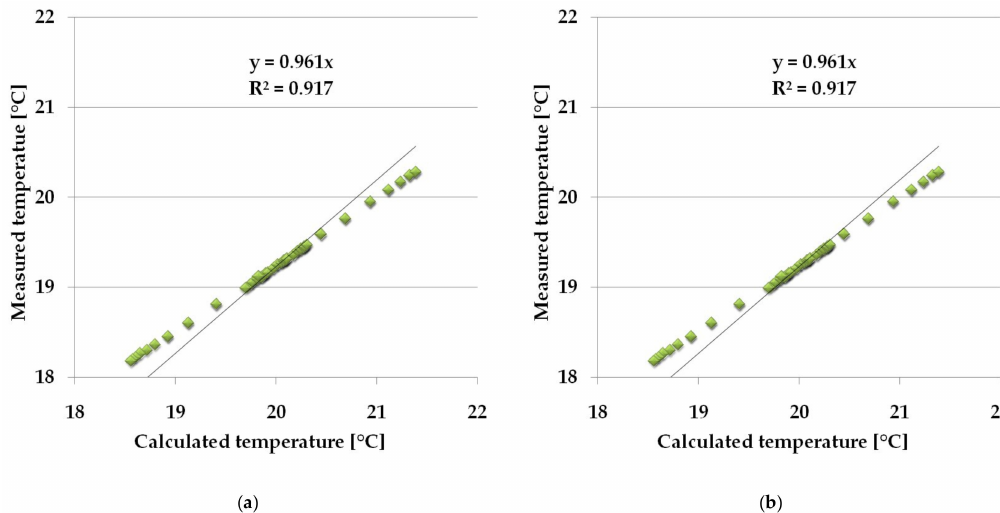
Figure 12. ( a ) Graph of the fit of empirical and theoretical values of the temperature of the window with a PCM accumulator; ( b ) Graph of the fit of empirical and theoretical values of the reference window